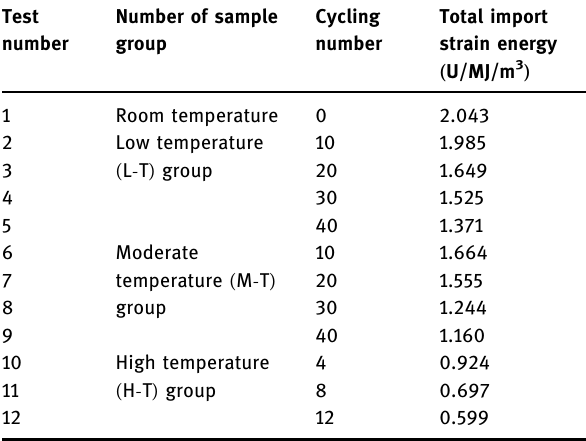
Table 2: The total import strain energy ( U ) under different test